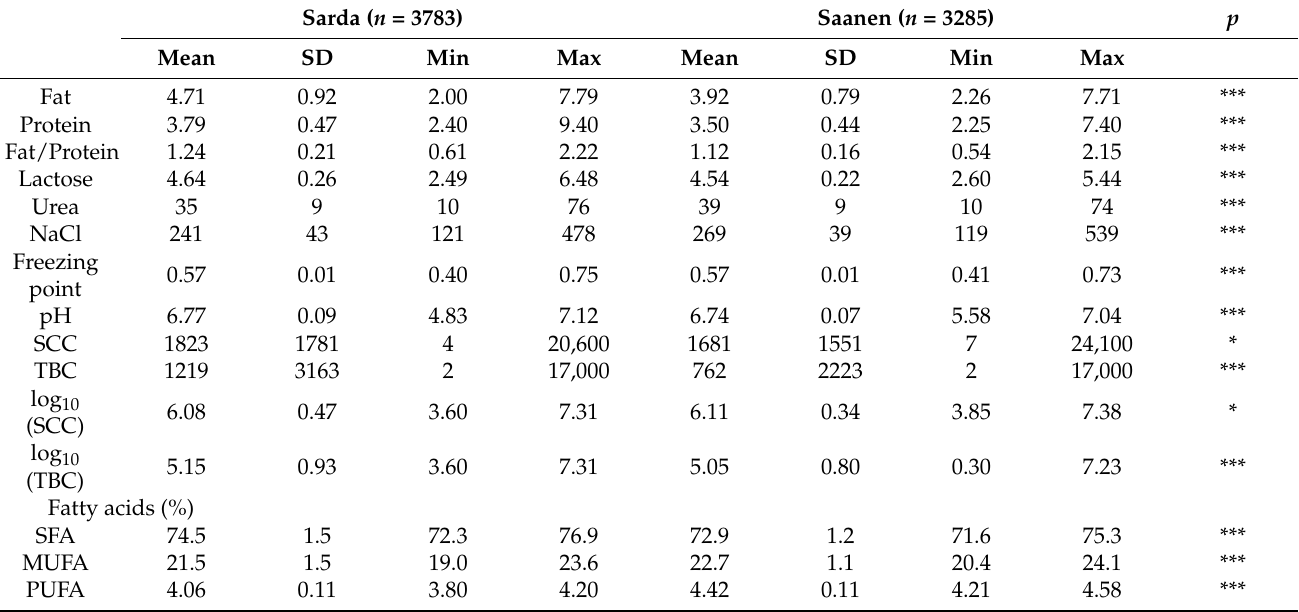
Table 1. Descriptive statistics and means comparison of goat milk parameters collected for four years.